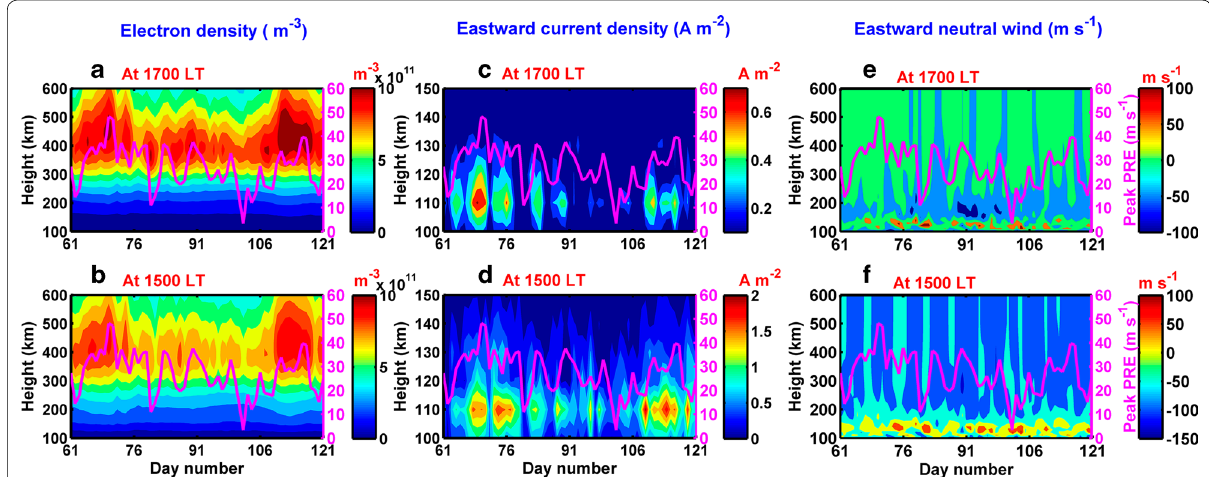
Fig. 4 Day-to-day variation of electron density ranging from 100 to 600 km (contour, in m − 3 ), eastward current density ranging from 100 to 150 km (contour, in A m − 2 ) and eastward neutral wind ranging from 100 to 600 km (contour, in m s − 1 ) along with peak PRE (magenta line, in m s − 1 ) over (10° N, 100° E; GAIA co-ordinates) near Chumphon in Thailand during March and April of 2012 at 1700 LT and 1500 LT